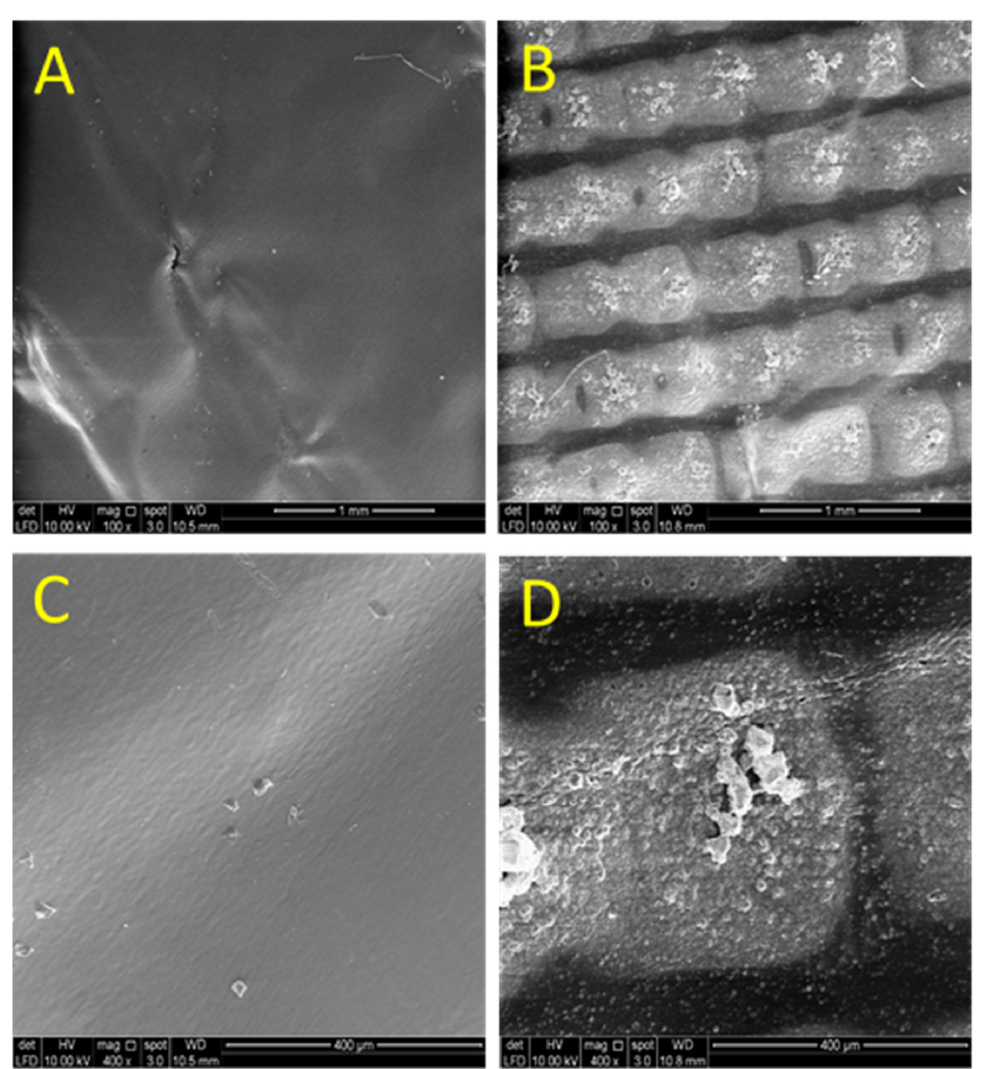
Figure 6. FESEM micrographs of S1 ( A , C ) and S2 ( B , D ) electrode taken at the surface at different magnifications: ( A , B ) 100× & ( C , D ) 400×. magnifications: ( A , B ) 100 × & ( C , D ) 400 ×